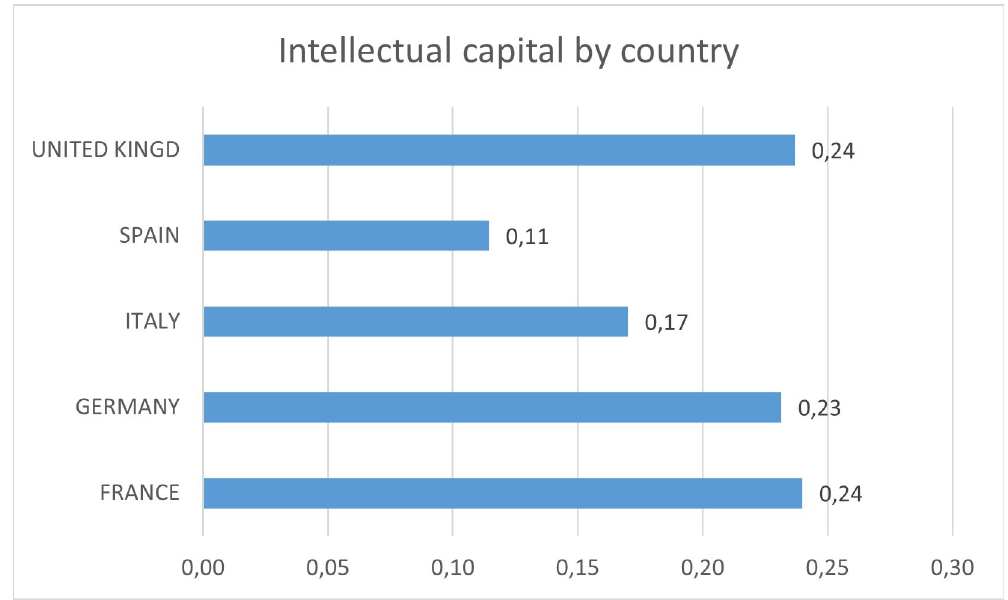
Fig 2. Percentage of intellectual capital stock on total assets by country.